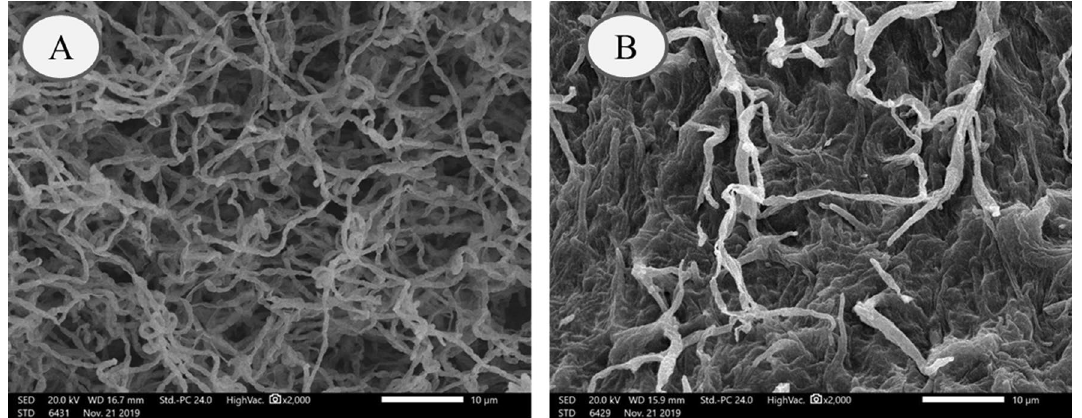
Figure 3. SEM micrographs of the biomass of S. rochei ANH (A) before and (B) after Cr 6+ biosorption (scale bar represents 10 μm).